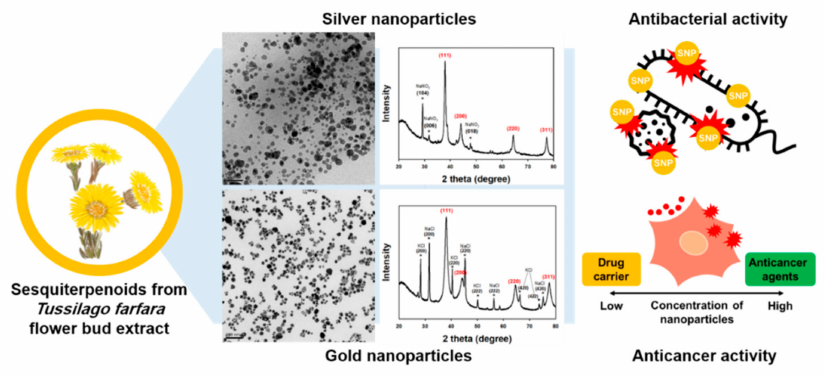
Figure 1. A schematic presentation of the current